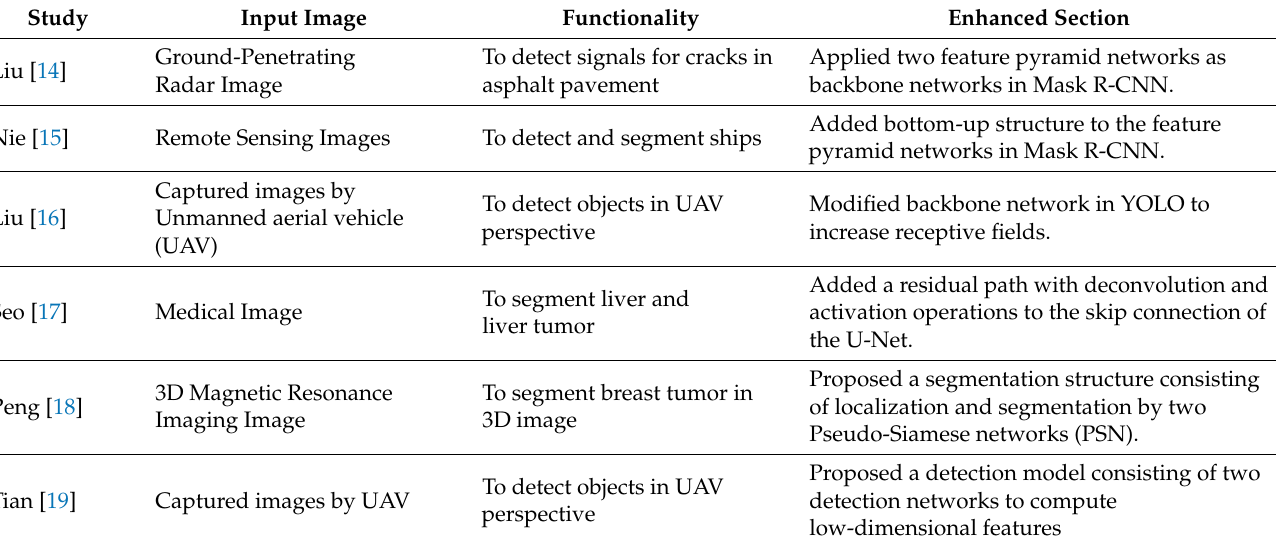
Table 1. Representative Studies for Detecting Small Size